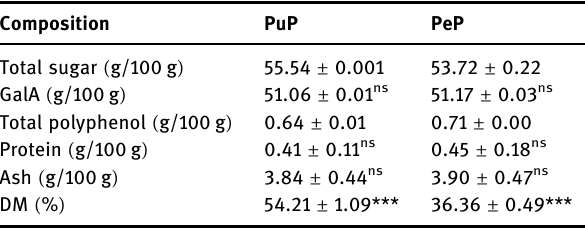
Table 1: Chemical composition and DM of PuP and PeP extracted